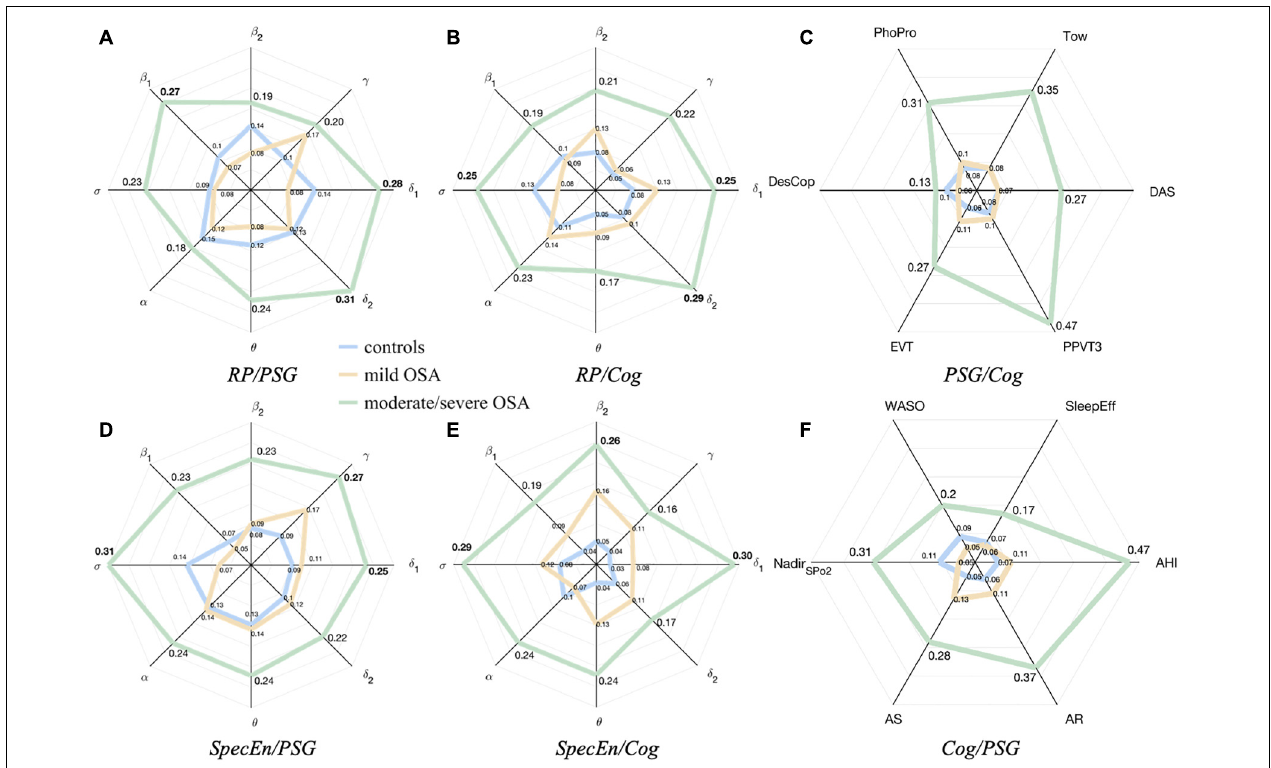
FIGURE 4 | Radar charts summarizing the averaged absolute correlation values between the sleep EEG, the PSG variables, and the cognitive scores. (A,B) correspond to relationships with EEG activity ( RP ). (D,E) correspond to relationships with EEG irregularity ( SpecEn ). (C,F) correspond to averaged correlations of PSG variables with each cognitive score and averages cognitive scores with each PSG variable. The distances from the center represent the average absolute correlations for controls (blue), mild OSA (yellow), and moderate/severe OSA